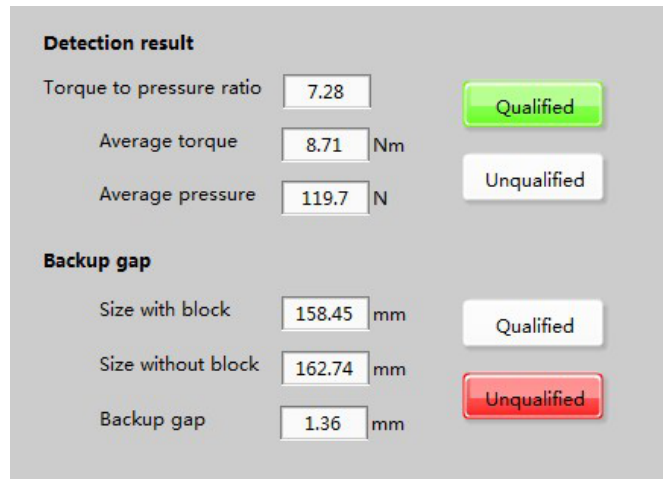
Figure 10. Synchronizer detection host. Appl. Sci. 201 9 , 8 , x FOR PEER REVIEW